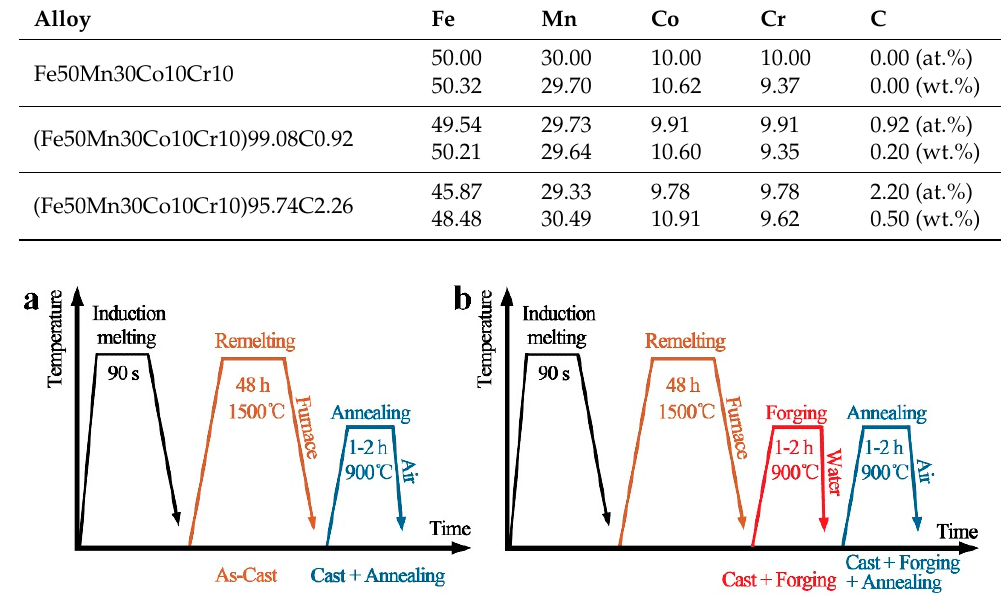
Figure 1. Sketch of the heat treatment process of the specimens. ( a ) heat treatment process of the as-cast (AC) and annealed as-cast specimen (AN); ( b ) Heat treatment process of the forged as-cast specimen (F) and the forged-annealed as-cast specimen (F-AN). Table 1. Chemical compositions of the alloys. Table 2. Measured chemical compositions after melting (wt.%).